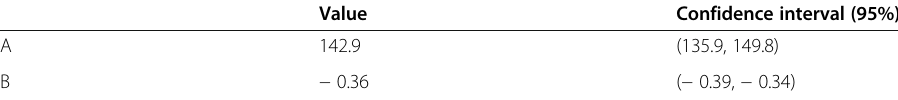
Table 1 Power curve best-fit parameters of absorbed dose uncertainty against volume